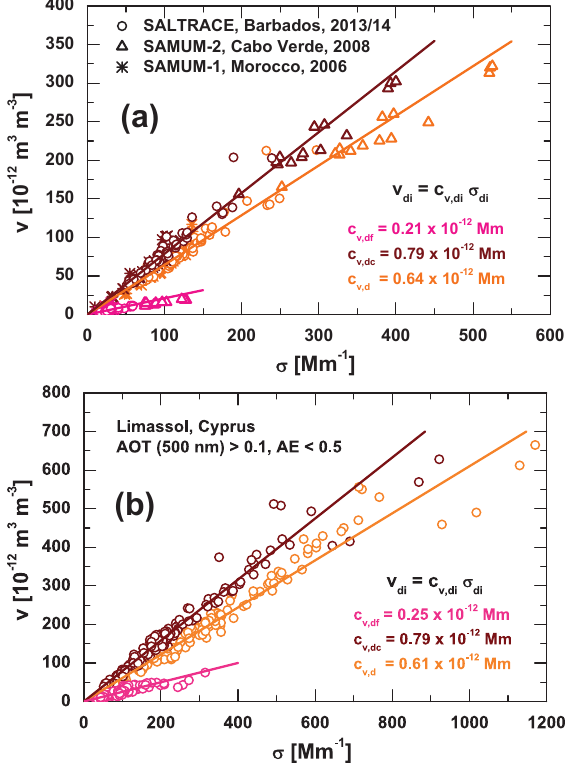
Figure 2. Relationship between the 532nm extinction coefficient σ and the particle volume concentration v considering (a) only pro- nounced dust outbreaks (116 observations on 41 days) during the SAMUM and SALTRACE campaigns in Morocco, Cabo Verde, and Barbados and (b) dust events over the AERONET station of Limas- sol, Cyprus (CUT-TEPAK site, 122 observations on 35 days in the period from July 2011 to June 2015). Correlations are separately shown between the total (orange), fine (pink), and coarse (dark red) dust extinction coefficient ( σ d , σ df , σ dc ) and the respective volume concentration ( v d , v df , v dc ). The slopes of the lines indicate the mean increase of v d , v df , and v dc with the respective σ d , σ df , and σ dc . The extinction-to-volume conversion factors c v , d , c v , df , and c v , dc are given as numbers in panels (a) and (b) and are also listed in Table. 2.